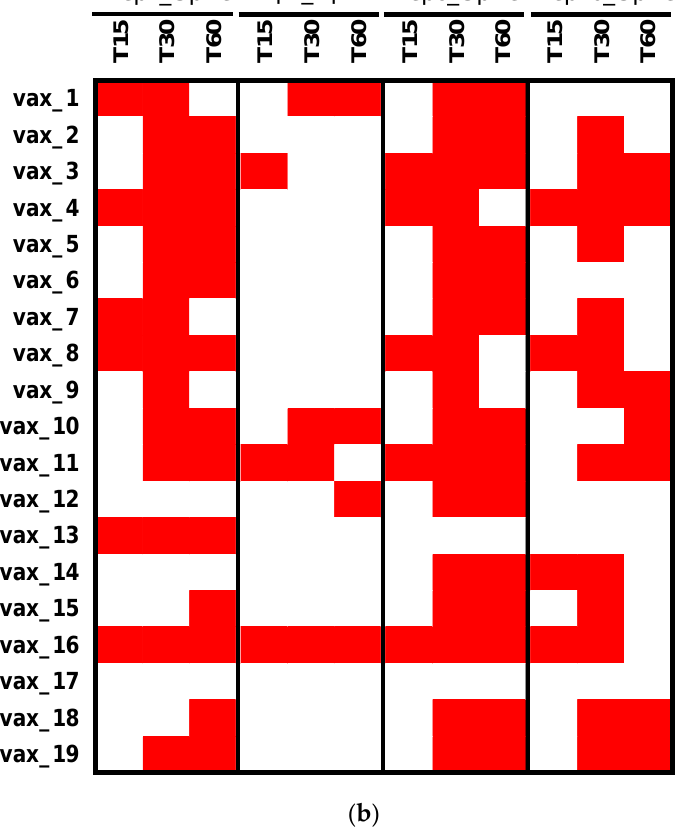
Figure 1. ( a ) IgG immunoreacting with the selected peptides at 15, 30, and 60 days following Pfizer/BioNTech administration of the first dose on day 0 and the second dose on day 21. The antibody response is reported as a log 2 fold-change compared to day 0. A positive response was arbitrarily scored for a log 2 fold-change >1.5. ( b ) Summary of IgG sero-reactivities shown in panel ( a ).